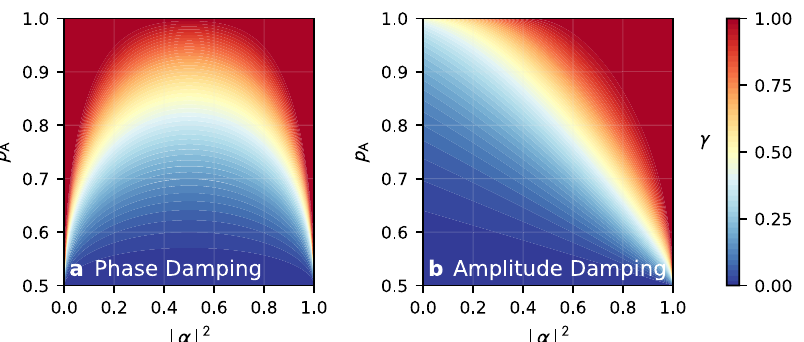
Fig. 4 Robustness against known noise models. Both plots show the maximal noise parameter γ for which the classi fi er A is still guaranteed to be robust, for ( a ) phase damping and ( b ) amplitude damping, when classifying a pure state input ψ j i ¼ α 0 j i þ β 1 j i . In a , we can see that for states 0 j i and 1 j i , the classi fi er is robust against any γ ≤ 1, while for ( b ) the same holds if the input state is 1 j i